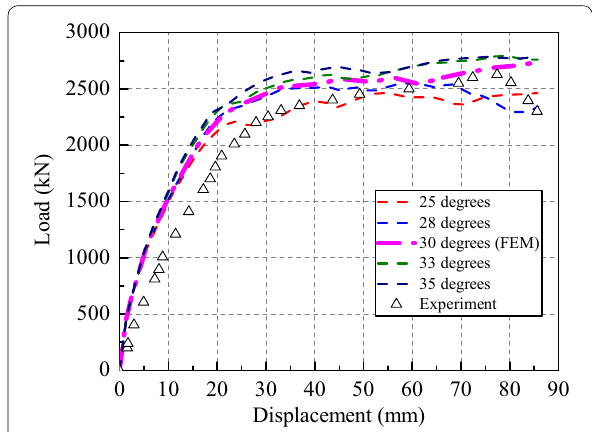
Fig. 24 Effect of the dilation